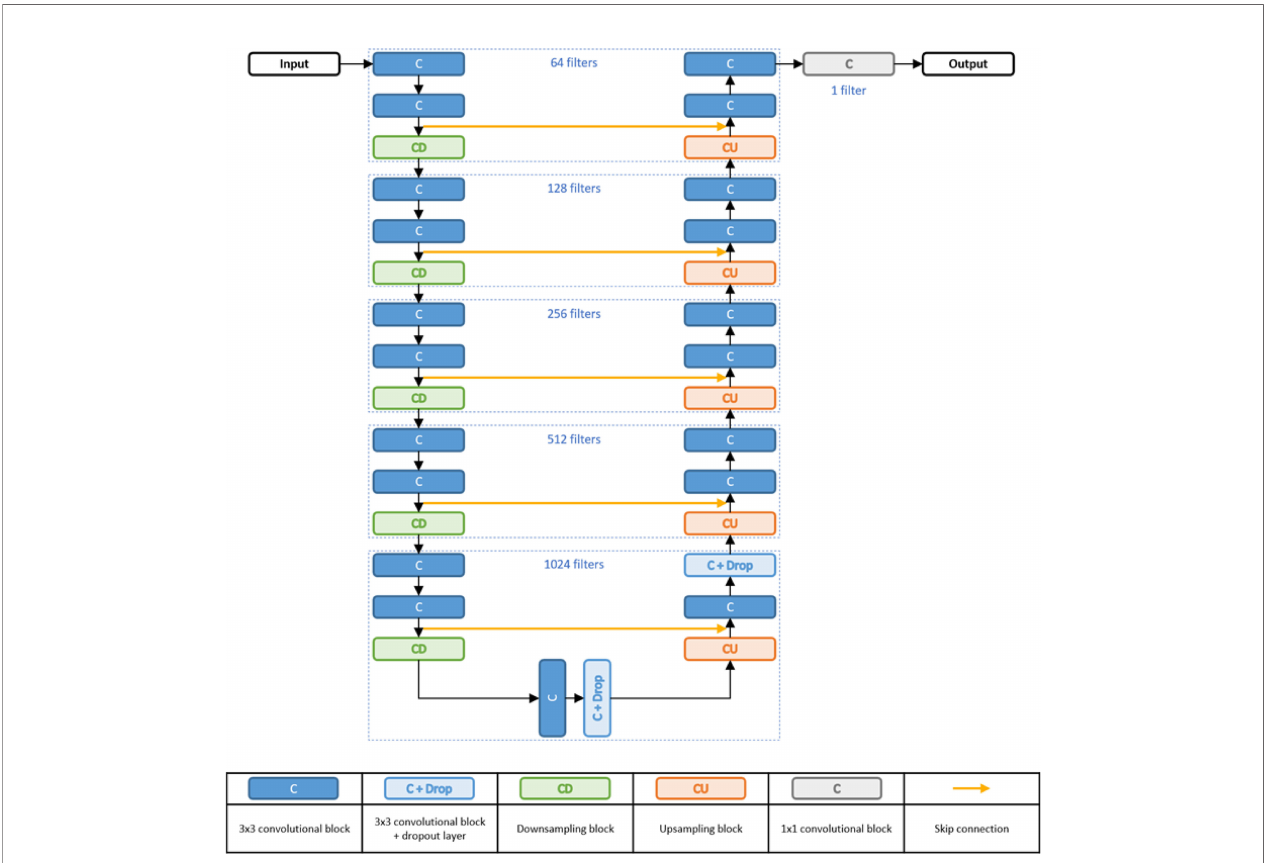
FIGURE 1 | Generator architecture. Note that the number of fi lters (i.e., 64 fi lters) indicates the number of fi lters in each convolutional